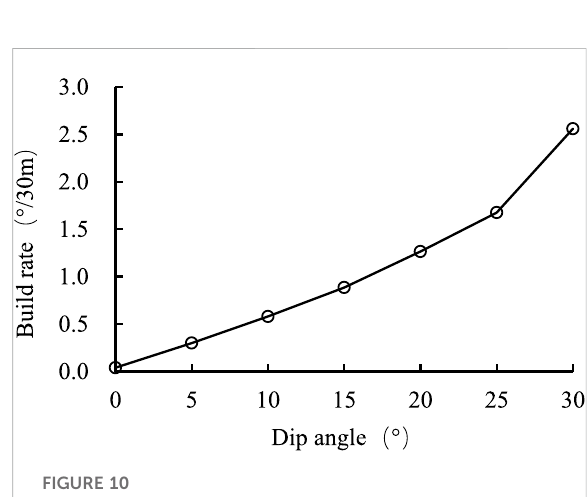
FIGURE 9 Bent-housing motor BHA build rates at different WOB.